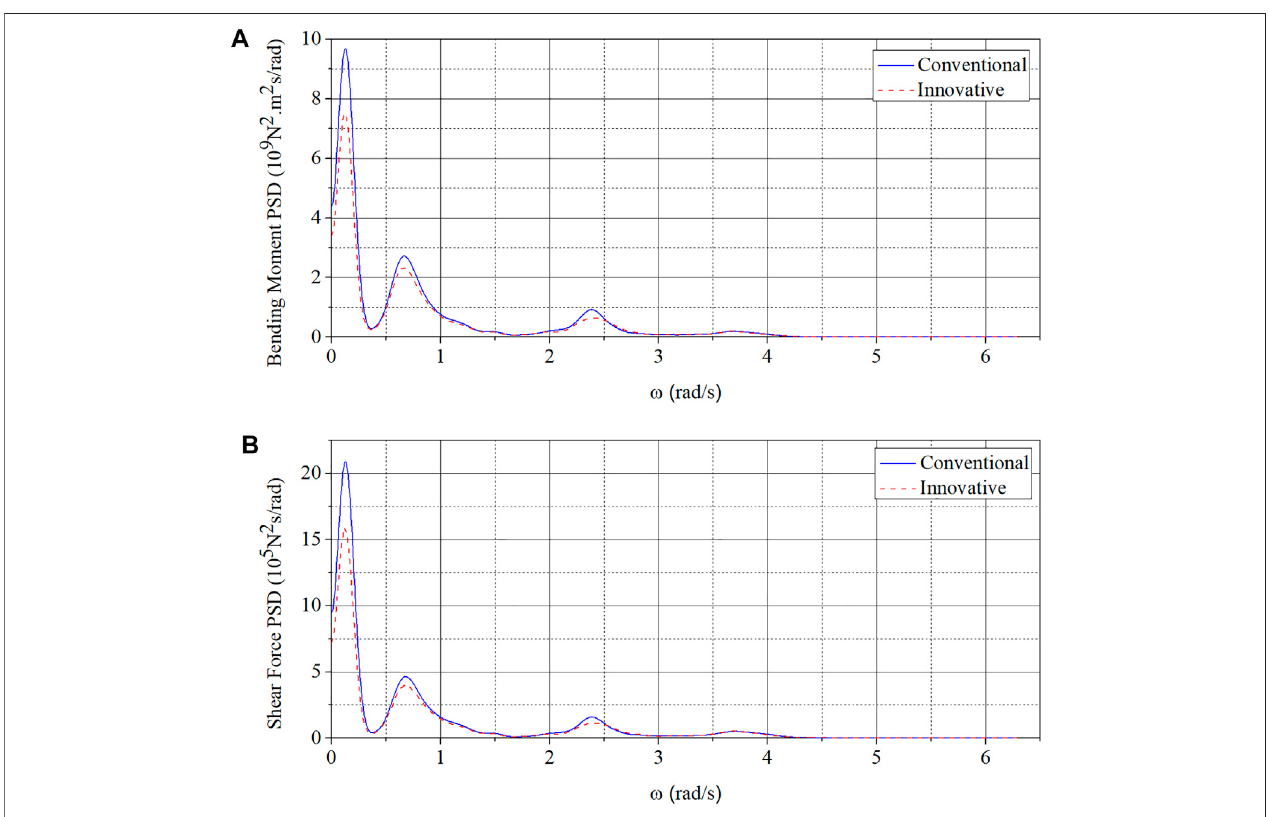
TABLE 5 | Structural loads statistics Items Conventional Innovative Increasing ratio Bending moments at tower